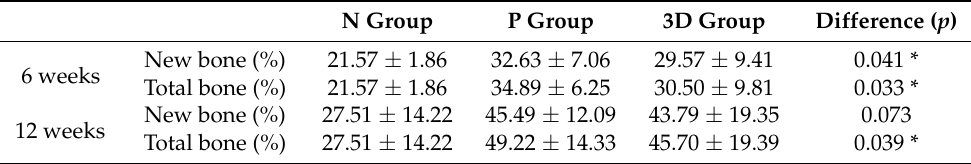
Figure 2. Radiological evaluation at the surgical site of each group at 6 and 12 weeks. At 6 and 12 weeks, the N group showed less bone regeneration at the defect site than the P and 3D groups (N group = negative group without graft, P group = positive group grafted with Bio-Oss, 3D group = study group grafted with 3D-printed ceramic block): ( a ) 6 weeks; ( b ) 12 weeks. Table 1. Radiological analysis of new bone formation in each group at 6 and 12